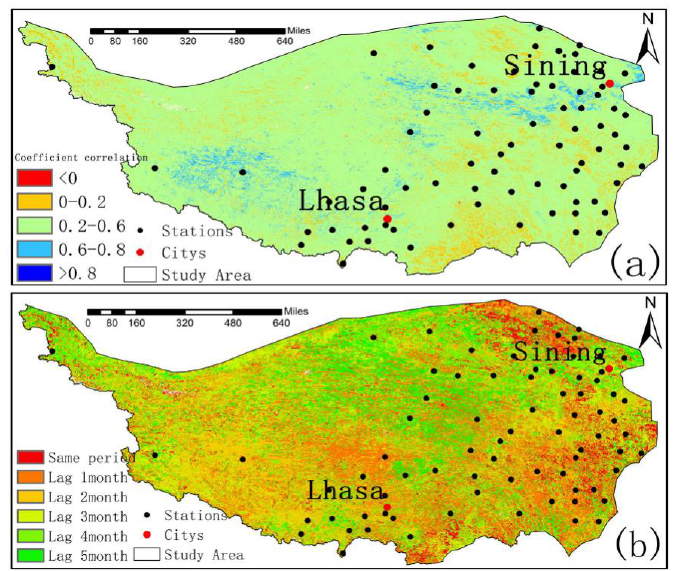
Figure 6. Spatial distribution of maximum cross-correlation ( a ) between NDVI and humidity index and time-lag response ( b ) in the Qinghai-Tibet region.